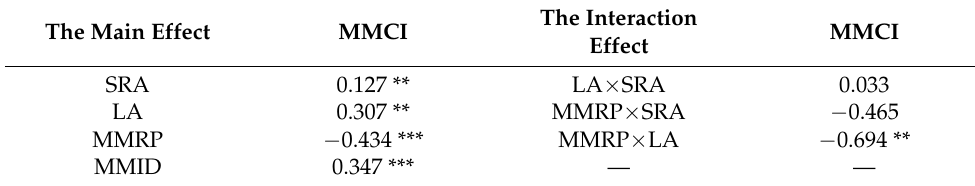
Table 4. Interaction between